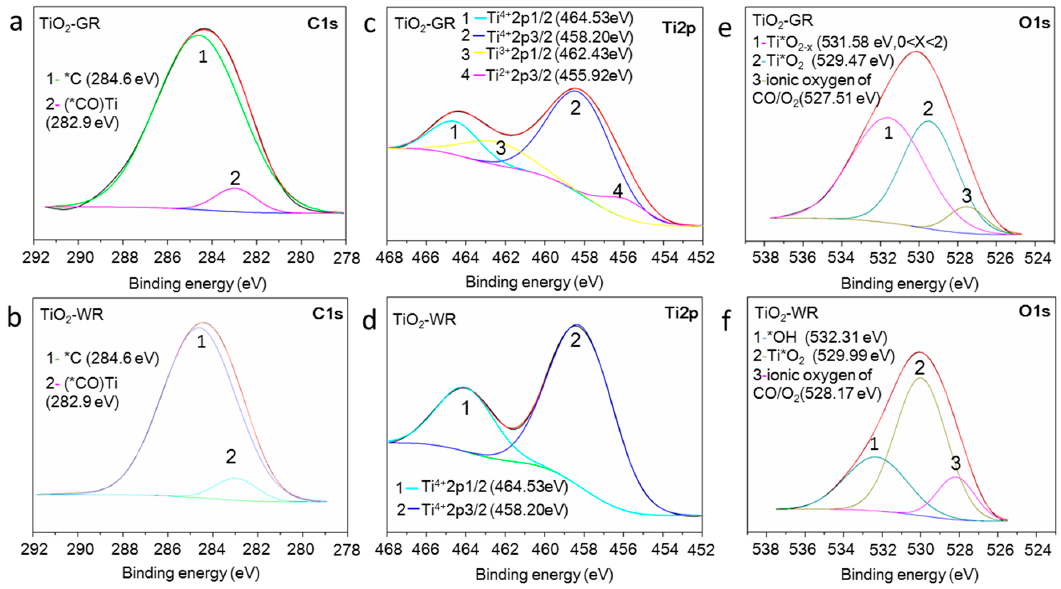
Figure 3. C 1s XPS spectra of TiO 2 -GR ( a ) and TiO 2 -WR ( b ); Ti 2p XPS spectra of TiO 2 -GR ( c ) and TiO 2 -WR ( d ); O 1s XPS spectra of TiO 2 -GR ( e ) and TiO 2 -WR ( f ).